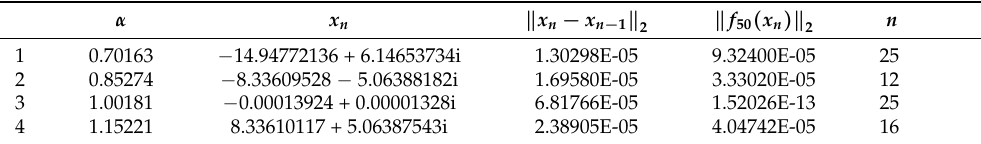
Table 5. Results obtained using the iterative method (50).